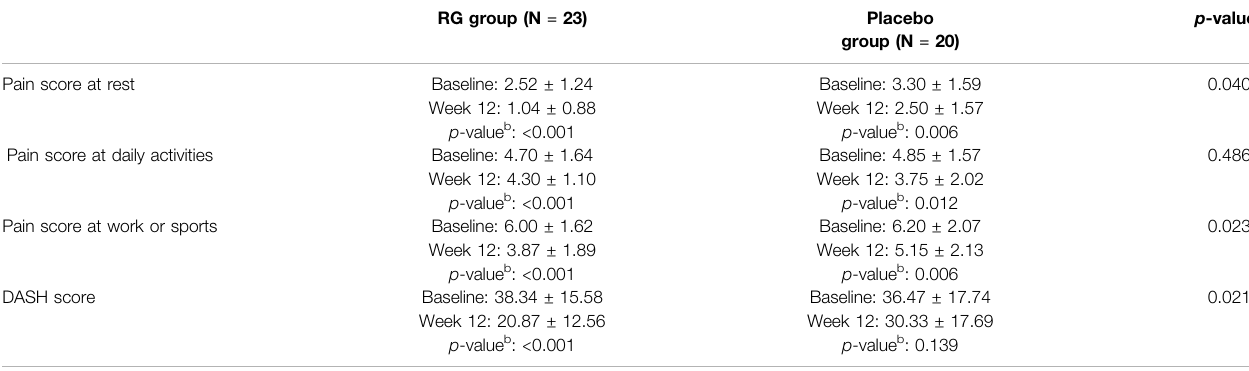
TABLE 5 | Pain score and disability of the arm, shoulder, and hand (DASH) scores at baseline and week 12.